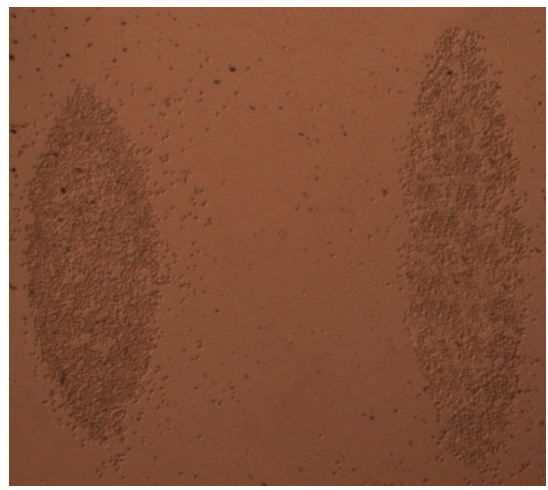
Figure 11. Model diagram of the secondary cascade lens composed of adherent cells.